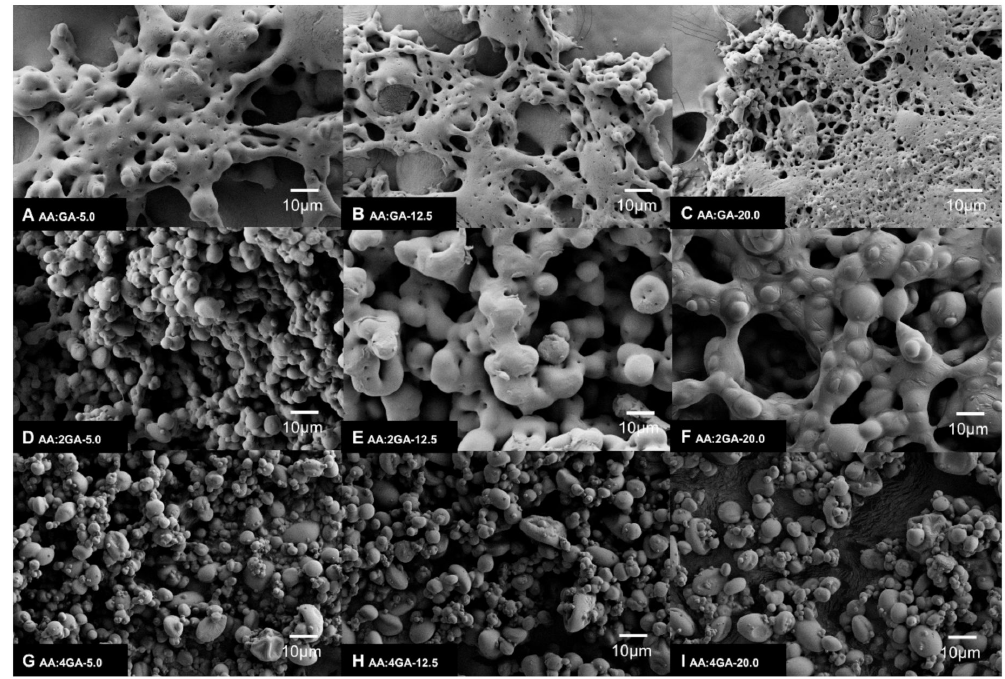
Figure 3. FE-SEM images of AA:GA-based microparticles from 5 g · L − 1 to 20 g · L − 1 of total dispersed solids and 1:1, 1:2 to 1:4 AA:GA-polymer ratio; ( A ) AA:GA-5.0, ( B ) AA:GA-12.5, ( C ) AA:GA-20.0, ( D ) AA:2GA-5.0, ( E ) AA:2GA-12.5, ( F ) AA:2GA-20.0, ( G ) AA:4GA-5.0, ( H ) AA:4GA-12.5, ( I )